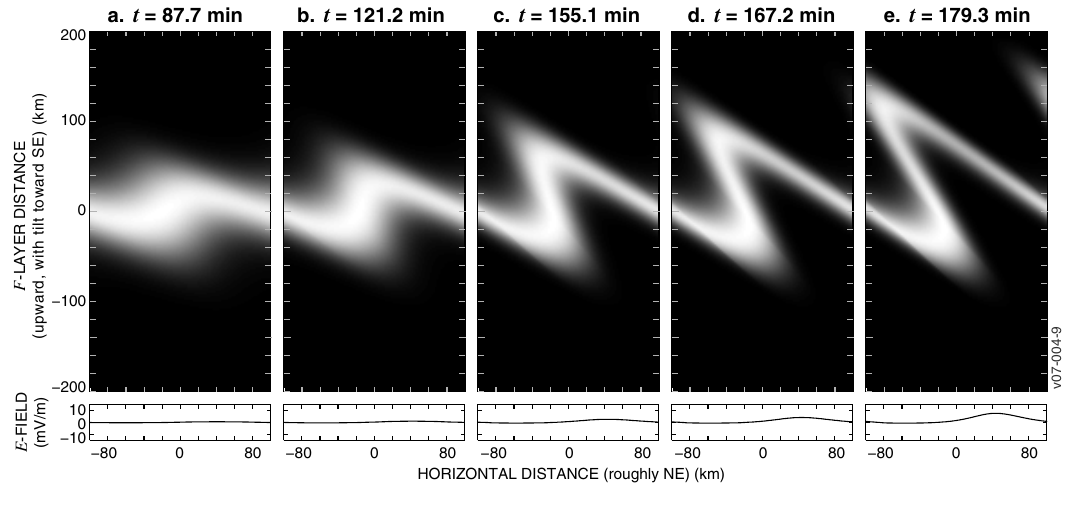
Figure 4: F layer evolution with no E s layer present (Perkins Instability), for a 200 km wavelength initial seed. The boundary conditions are periodic in the horizontal direction. The axes are described in the first paragraph of Section 4, and summarized in Figure 3.